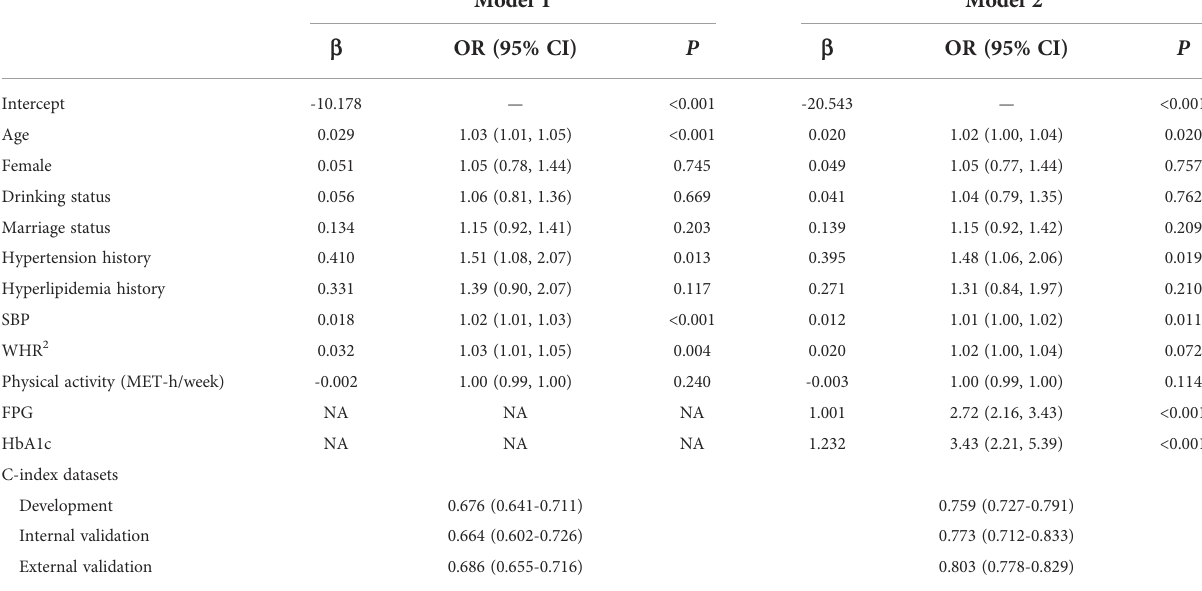
TABLE 2 Risk of factors for isolated high 2-hour plasma glucose in the development dataset 1 .